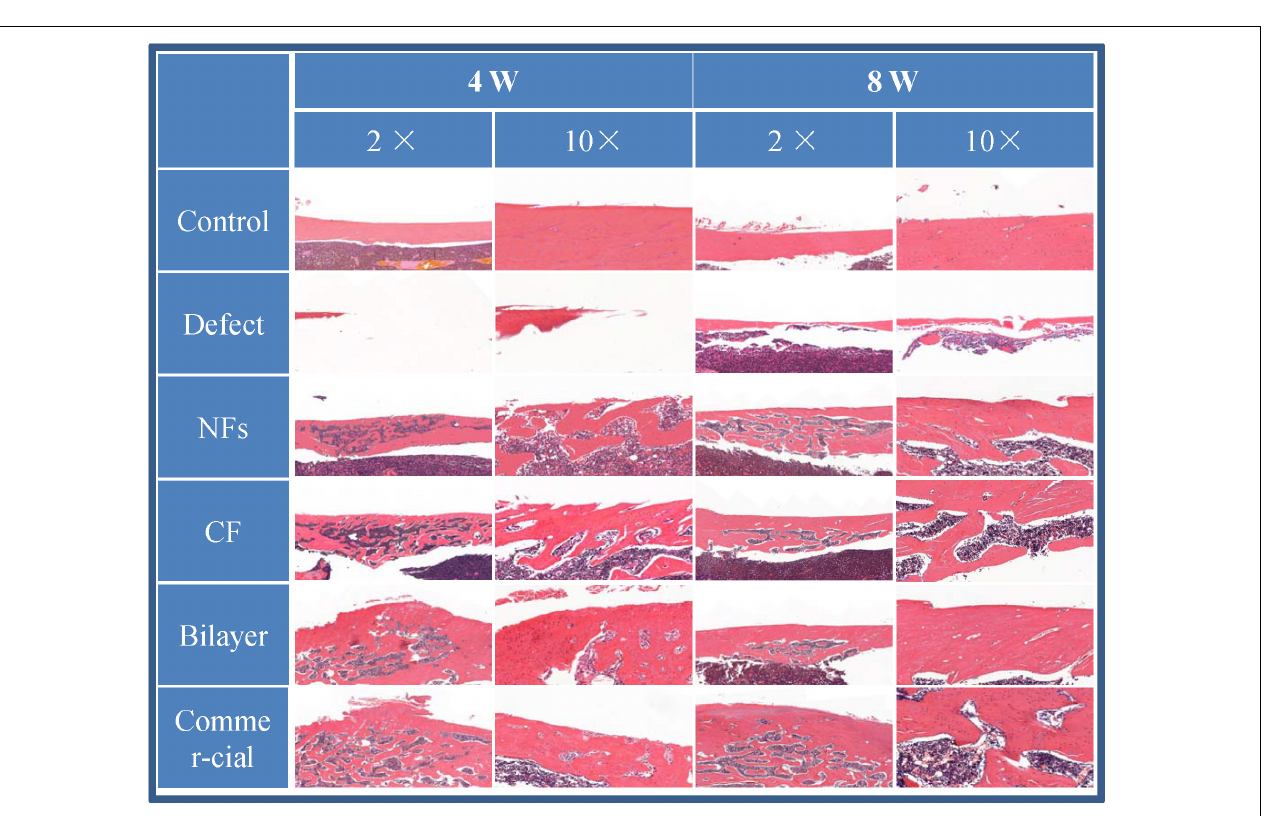
FIGURE 10 | H&E staining of the bone defect after 4 and 8 weeks of